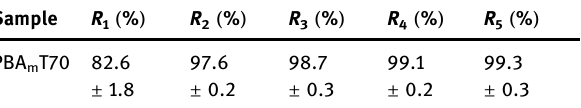
Table 3: Tensile properties of PBA m T70 Sample